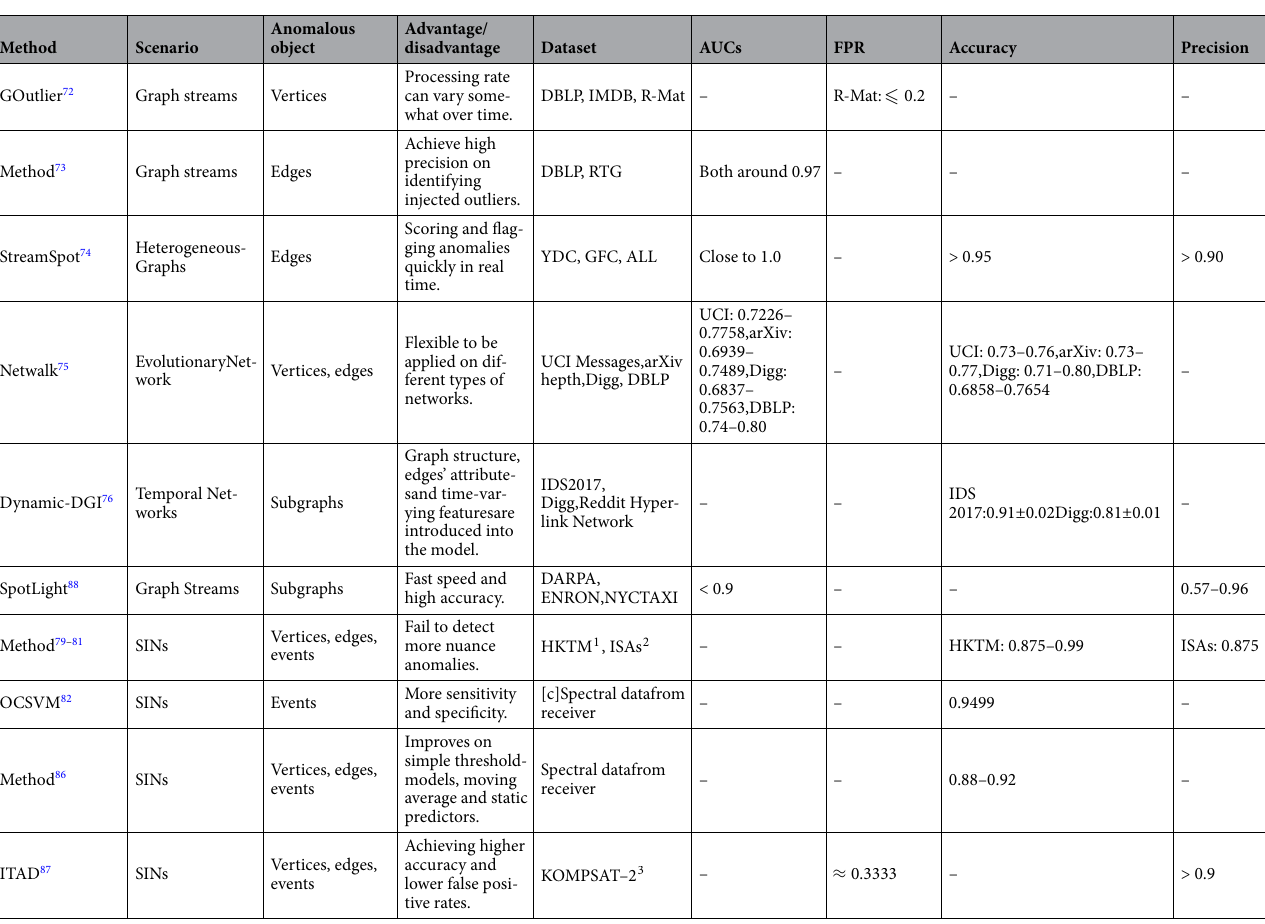
Table 4. Comparison of anomaly detection methods in SINs. 1 The HKTM (House Keeping